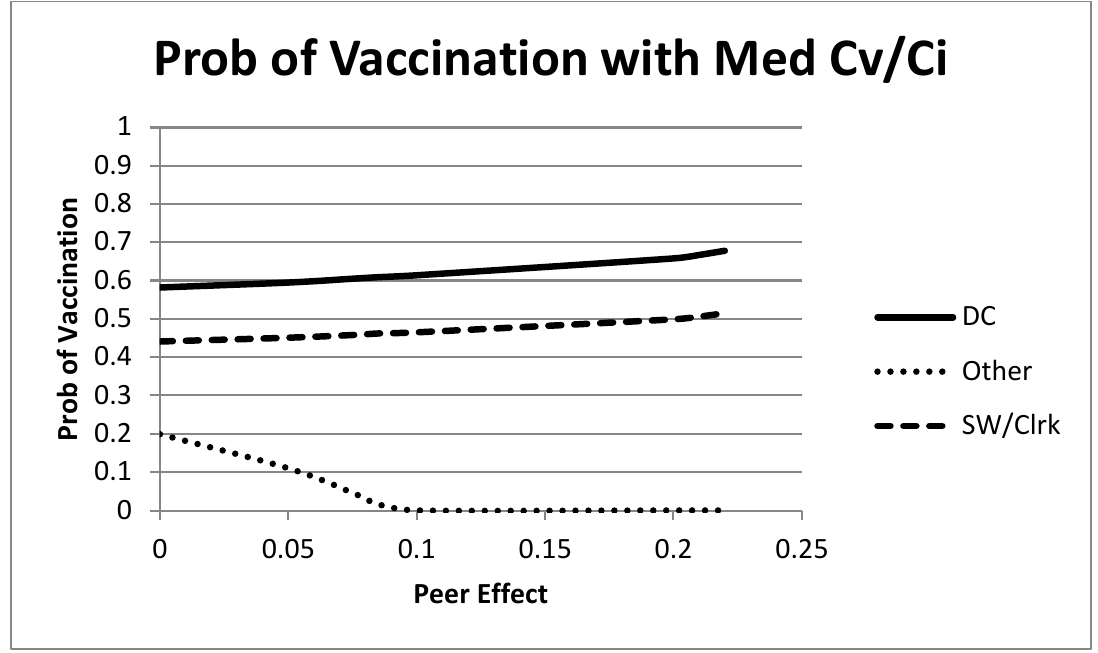
Figure 5. Mixed strategy equilibrium vaccination choices as a function of the size of the peer effects. In this figure, λ is an intermediate value, λ = 0 . 10 . At this level of λ , the direct care and social worker/clerk groups increase their equilibrium vaccination rate, and the “remaining” group decreases their equilibrium vaccination rate as peer effects